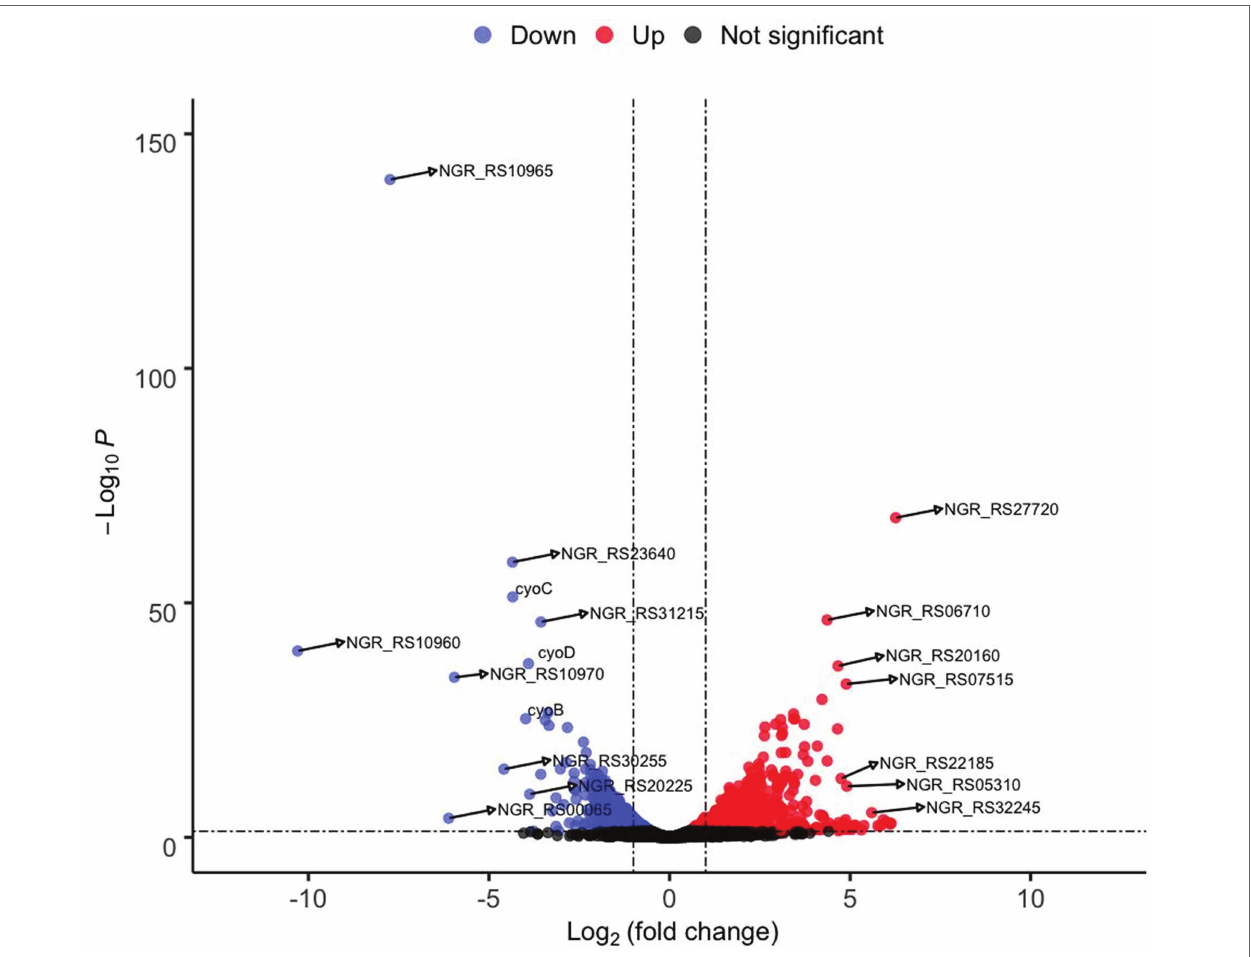
FIGURE 3 | Volcano graph showing fold change in expression of genes in the Δ rpuS S. fredii strain compared to the parental strain (NGR234) when growing on pyruvate. Cultures were inoculated to a A 620 of 0.1 in minimal medium supplemented with pyruvate and incubated at 150 rpm and 30 ° C for 12 h. RNA was isolated from 500 μ l aliquots. Colored dots indicate upregulated (red) and downregulated (blue) genes. Labeled dots correspond to some of the genes listed in Table 2